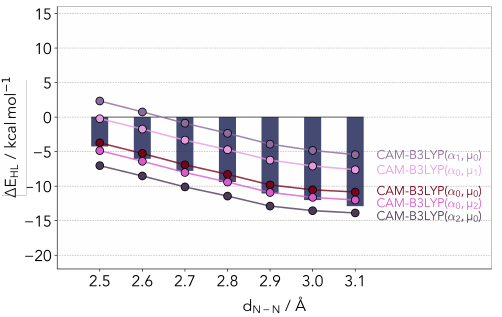
Figure 4. Comparison of ∆ E HL values computed with refitted CAM-B3LYP. The bars depict the reference coupled cluster values. α 0 , µ 0 are the original parameters. α 1 = 0.13, α 2 = 0.25, µ 1 = 0.25, µ 2 =